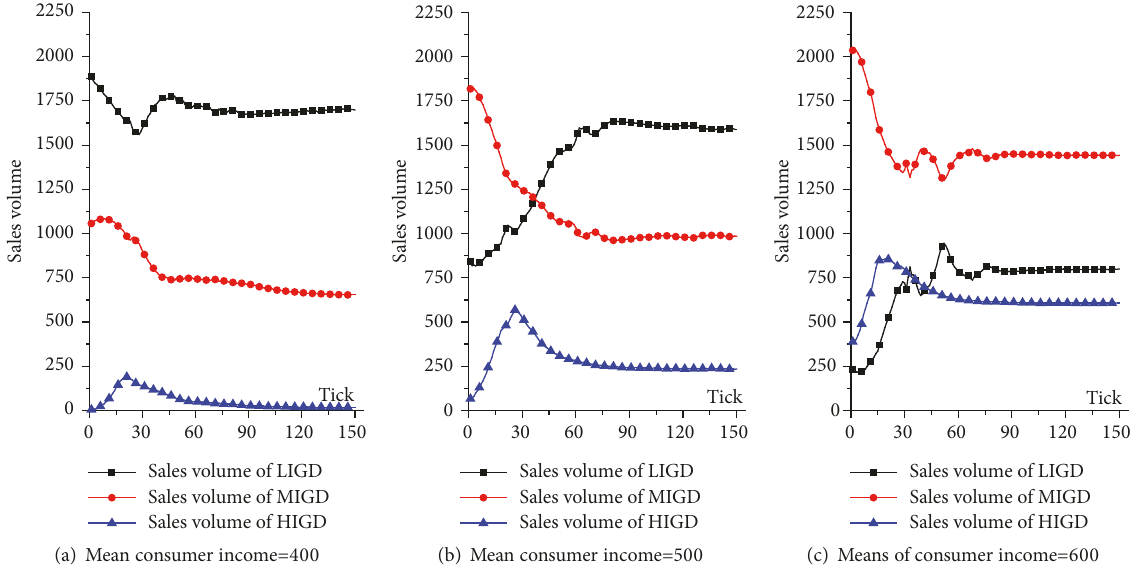
Figure 5: Sales evolution of three manufacturer categories under different